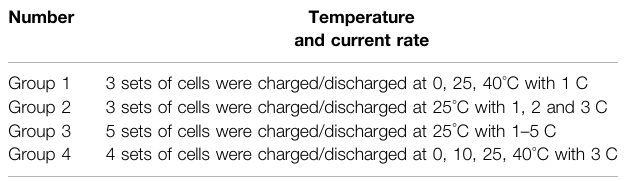
TABLE 3 | Sets of experiment groups.